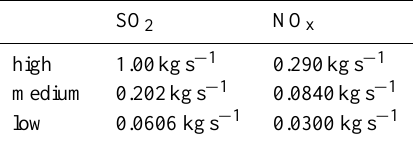
Table 4. Emissions rates for coal-fired power plants in the USA from the 2010 EPA CAM data. “Medium” emissions are defined as the log-space mean, “high” as one standard deviation above the mean, and “low” as one standard deviation below the